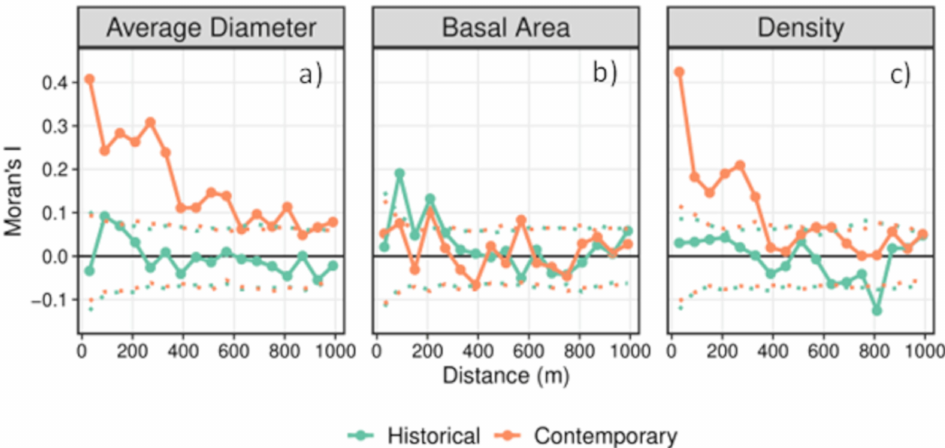
Figure 6. Correlograms of historical and contemporary forest structure. Each panel displays the spatial autocorrelation (as measured by Moran’s I) for historical and contemporary conditions (differ- entiated by color). Points connected by solid lines indicate the Moran’s I at a given lag distance, and the dotted lines indicate the upper and lower limits of no significant spatial autocorrelation using 95% confidence envelopes. Points that are above the threshold are significantly spatially autocorrelated, points that are below the threshold are significantly negatively autocorrelated. Historically, measures of forest structure were generally not autocorrelated. Contemporarily, average diameter and density are both significantly